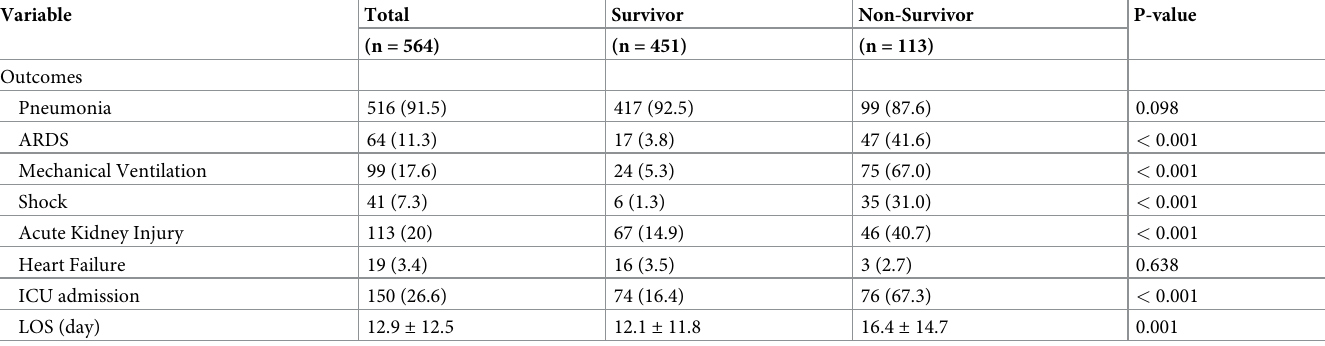
Table 3. The clinical outcomes among survivors and non-survivors of patients with